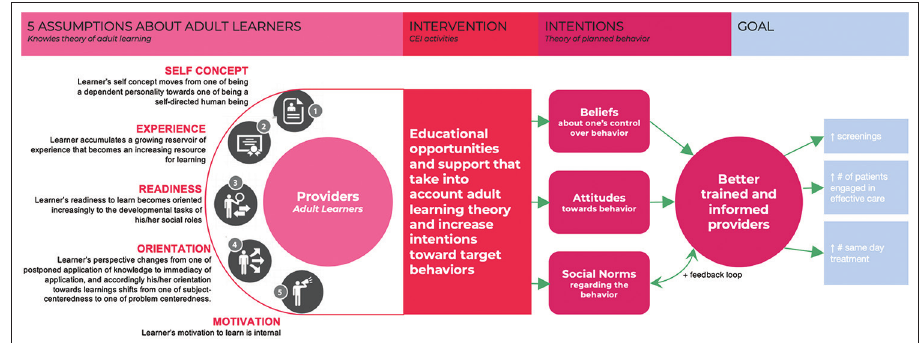
Figure 1: Rapid Initiation of ART Logic and Learner